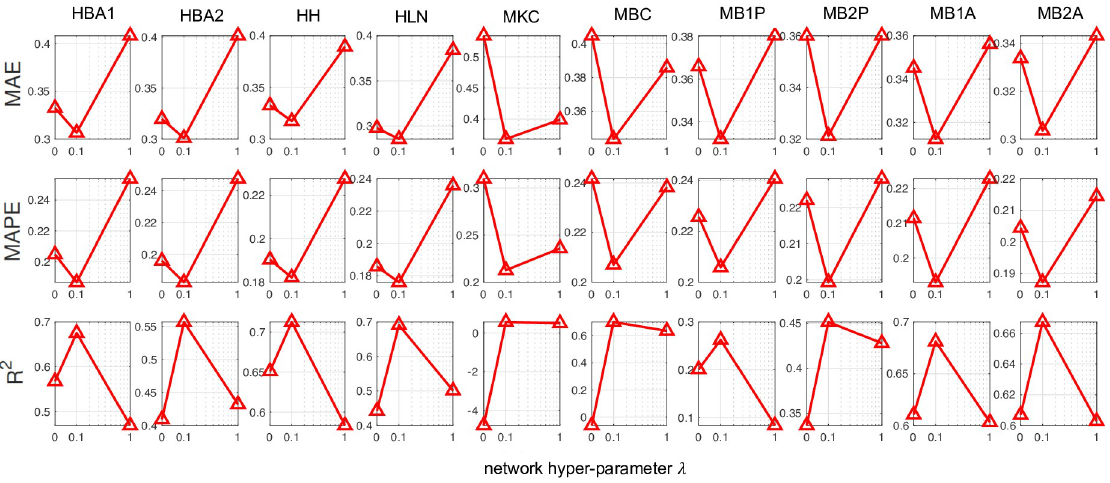
Fig 4. Analysis of Cartesian product graph regularization with varying network hyper-parameter in spot-wise evaluation. The plots show the imputation performance of FIST on the ten 10x Genomics datasets with varying network hyper-parameters in {0, 0.1, 1} by MAE, MAPE and R 2